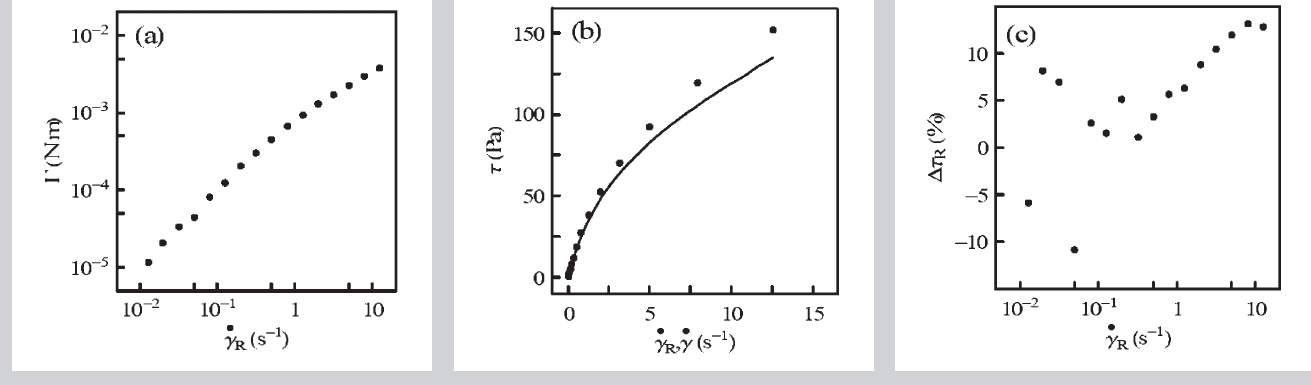
Figure 3: Data and results of hydroxypropyl methylcellu- lose